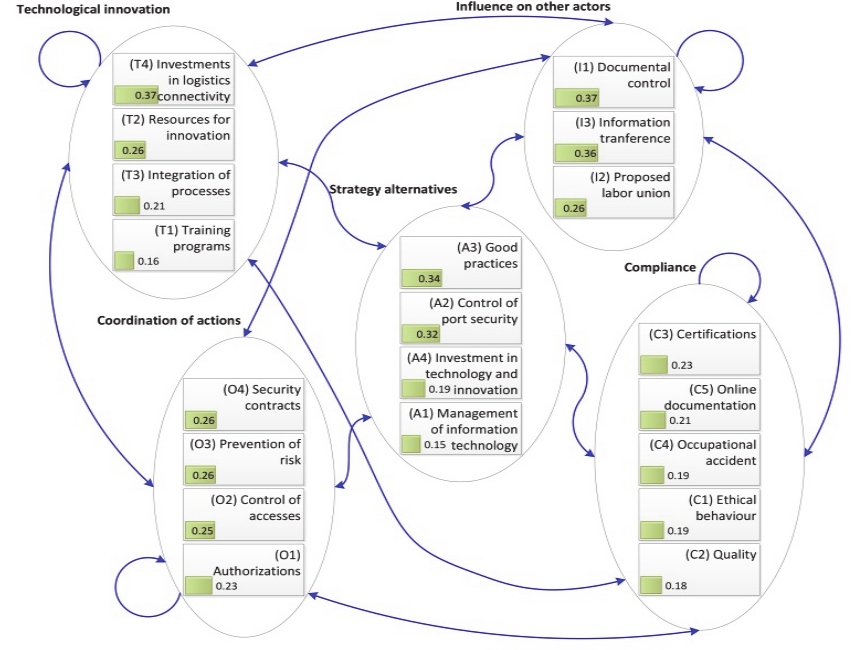
Fig. 7. ANP model of the Port